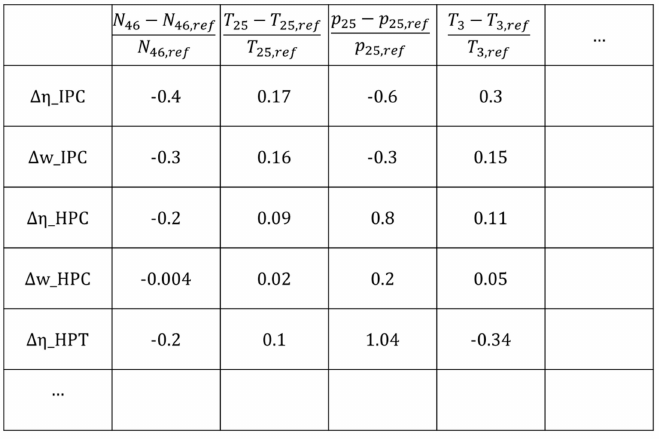
Figure 2. Illustrative example of influence matrix H